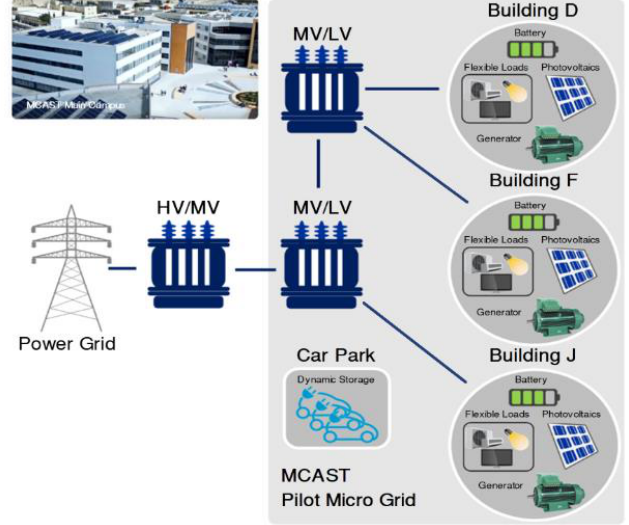
Figure 2. MCAST micro-grid—Electrical Network .